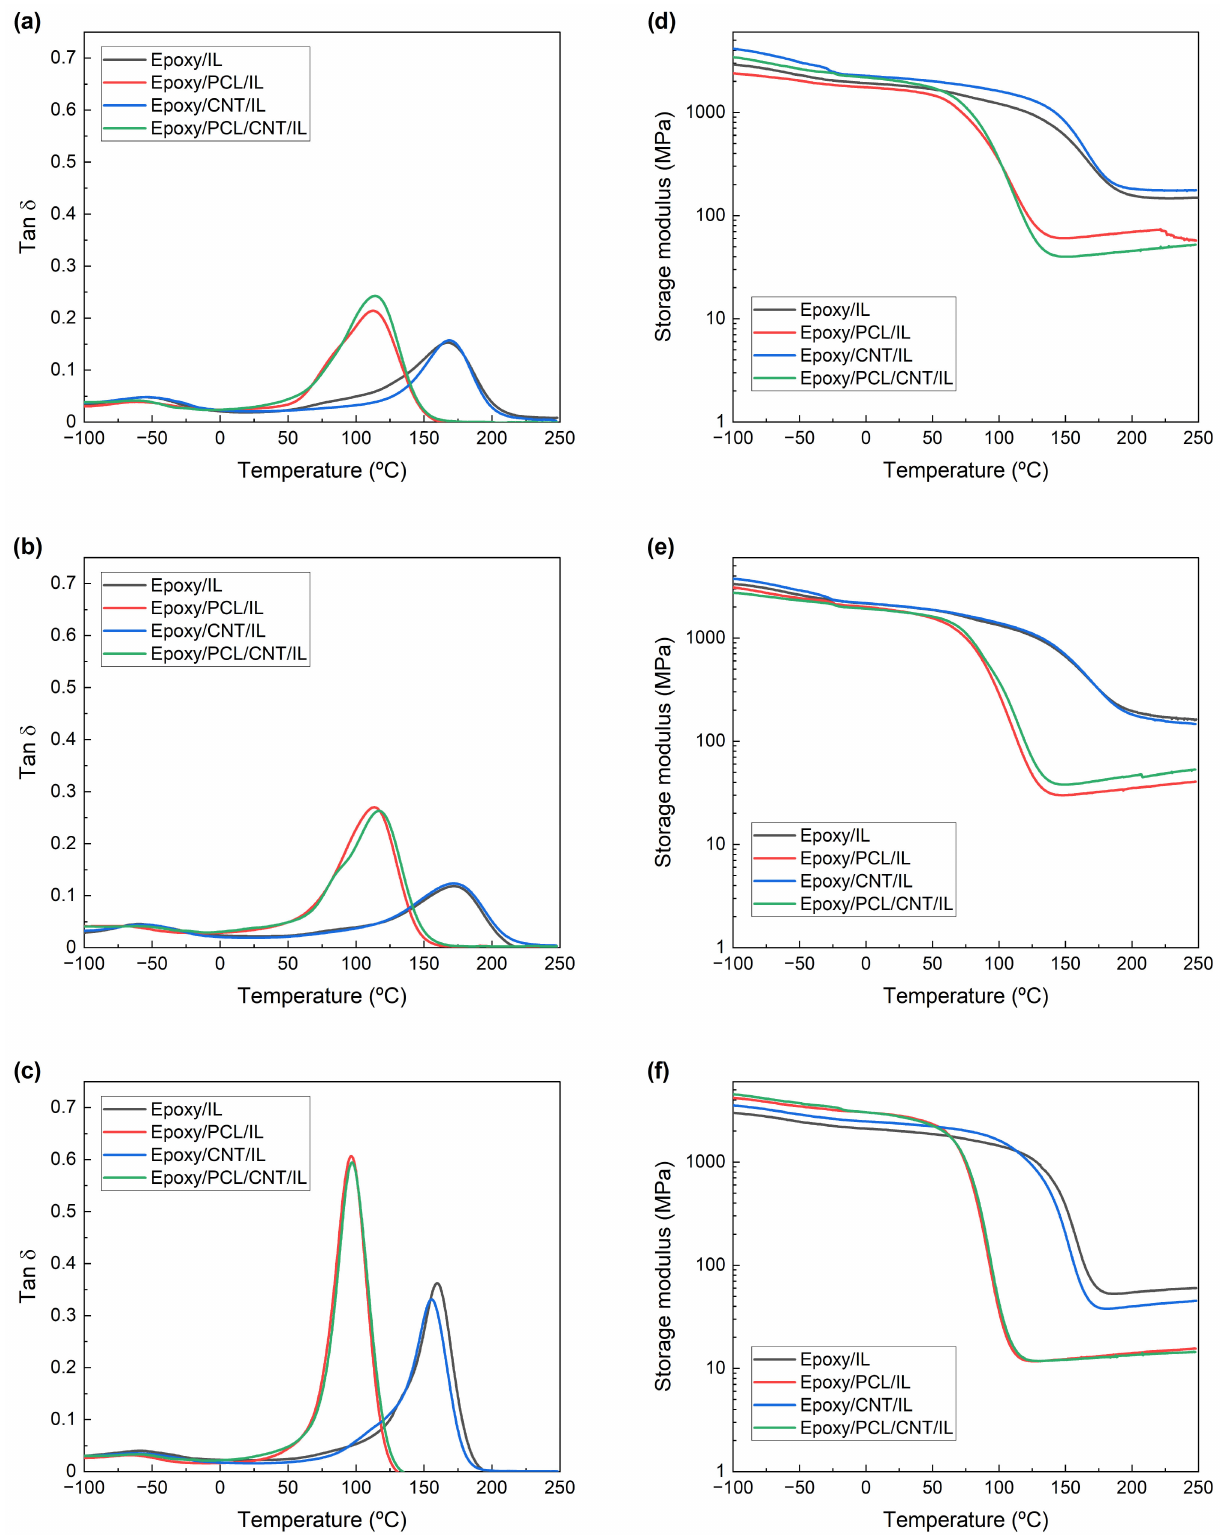
Figure 1. The tan δ ( a – c ) and storage modulus ( d – f ) vs. temperature curves of the epoxy/IL, epoxy/PCL/IL, epoxy/CNT/IL, and epoxy/PCL/CNT/IL systems cured with IL-P-TMPP ( a , d ), IL- P-DCA ( b , e ), and IL-I-DCA ( c , f